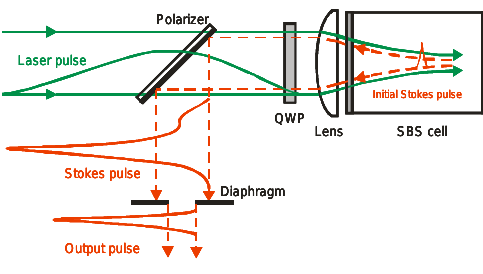
Figure 1. A schema of the SBS